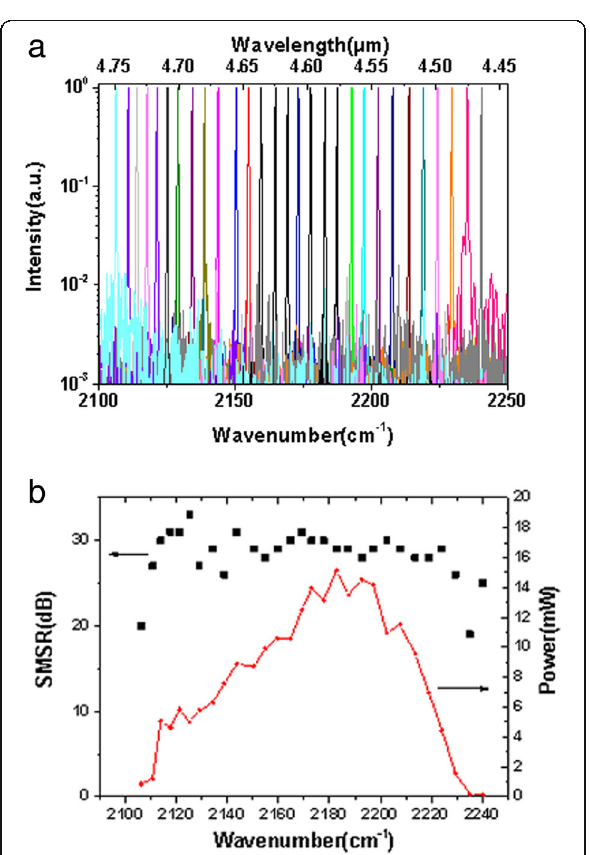
Fig. 2 a The normalized emission spectra of the EC-QCL measured at 25 °C in cw operation with the current of 330 mA. The adjacent spectrum was measured with the galvanometer rotating step of 0.1°. b Measured output power (red curve) and SMSR (black point) of the EC-QCL at different scanning galvanometer